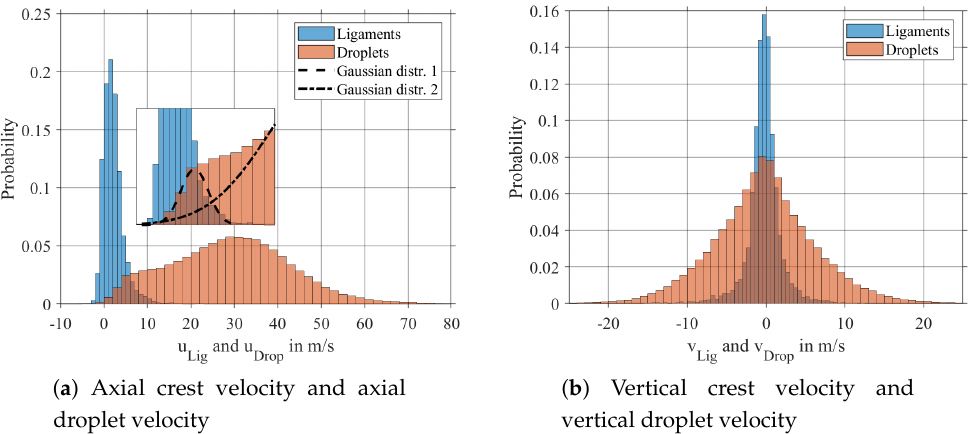
Figure 13. Velocities of ligament crest and droplets for p g = 5bar, u g = 70m/s, h a =